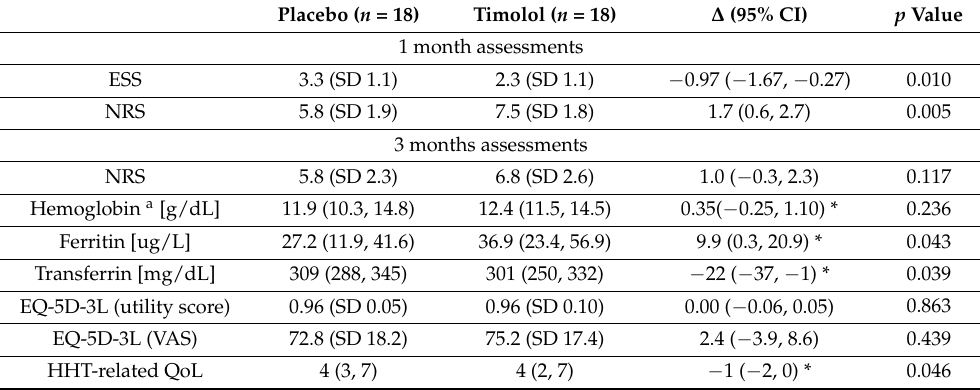
Table 3. Secondary